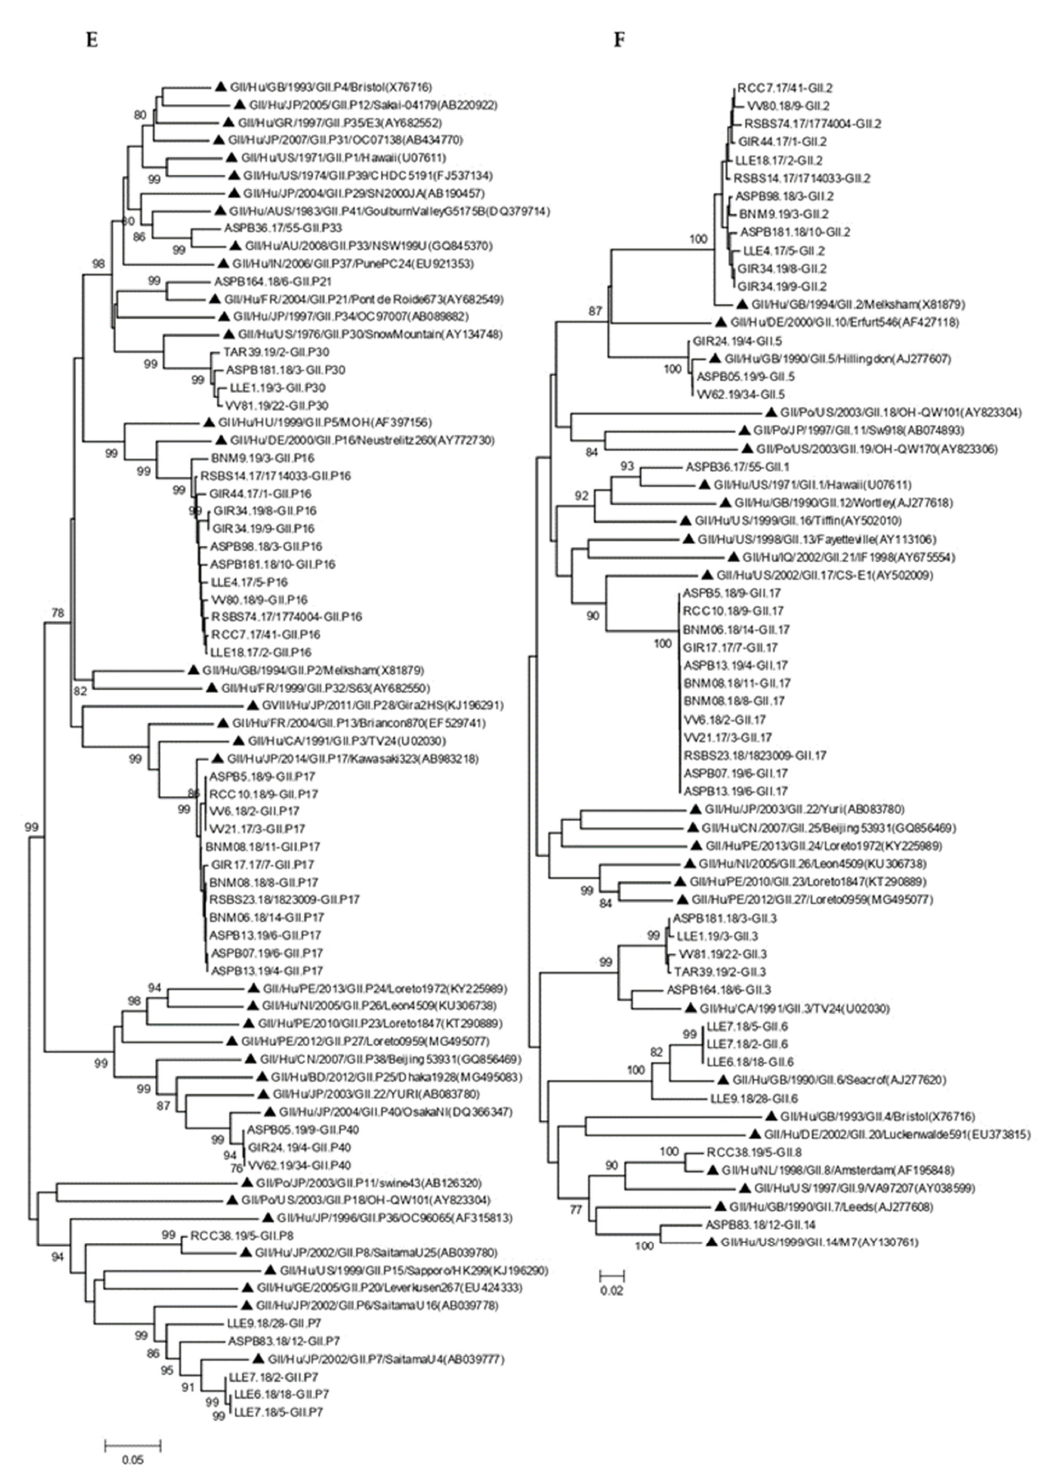
Figure 3. Phylogenetic analysis of HuNoV strains isolated in outbreaks of gastroenteritis, based on RdRp ( A , C , E ) and VP1 regions ( B , D , F ). Panels A and B include all GI genotypes, panel C and D include all GII genotypes except GII.4, and panels E and F include all GII.4 variants. Bootstrap values above 75 are shown in the figure. Trees are drawn to scale, with branch lengths in the same units as those of the evolutionary distances used to infer the phylogenetic tree. Symbol indicates reference strains for the respective genotypes. Isolate names are composed of a letter code indicating the geographic region followed by the outbreak number, the year, and sample